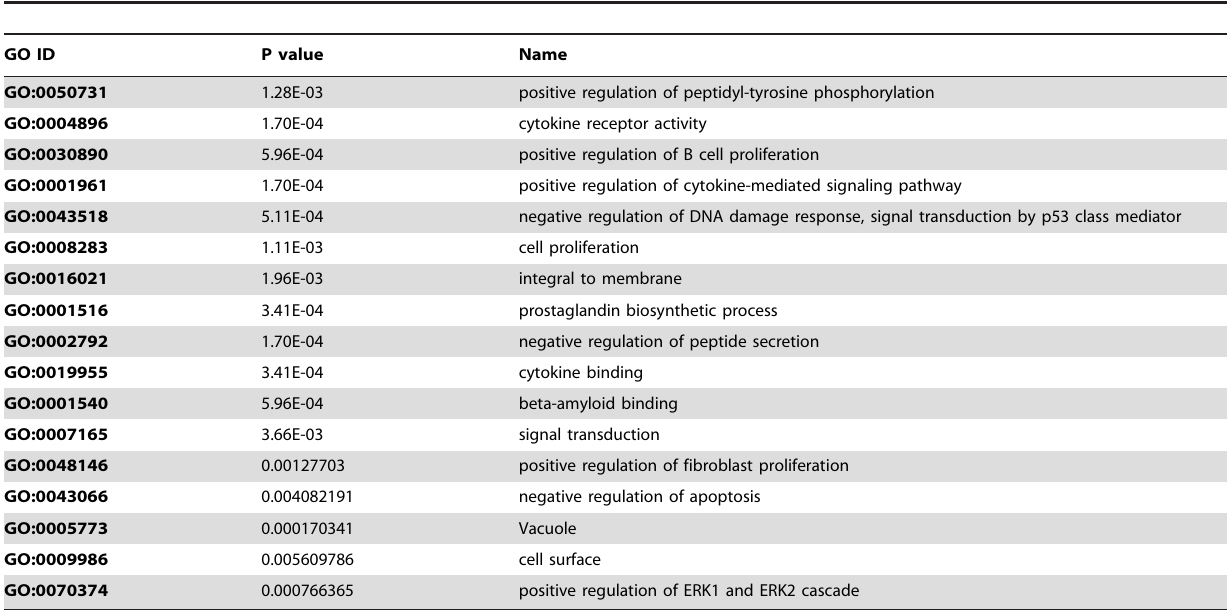
Table 1. Significant functions (P value , 0.01) of the progression-related sub network deregulated initially from hepatitis C.